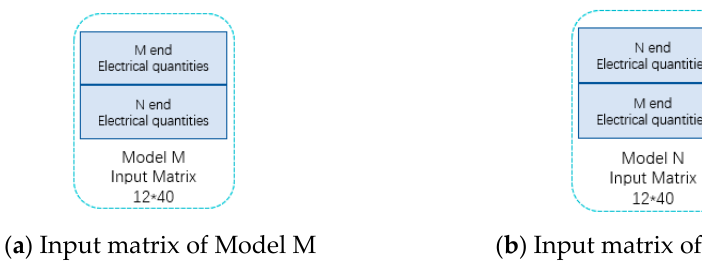
Figure 5. Input matrix of Model M and Model N.